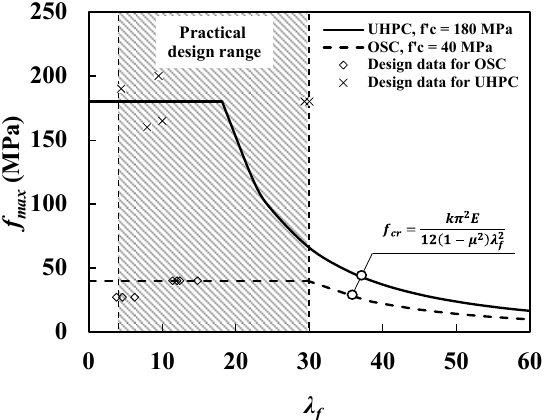
Figure 1. A comparison between theoretical elastic local buckling strength ( f cr ) with respect to the slenderness ratio ( λ f ) and practical design range of UHPC and ordinary strength concrete (OSC) for compression bridge decks (data from reference [23]).